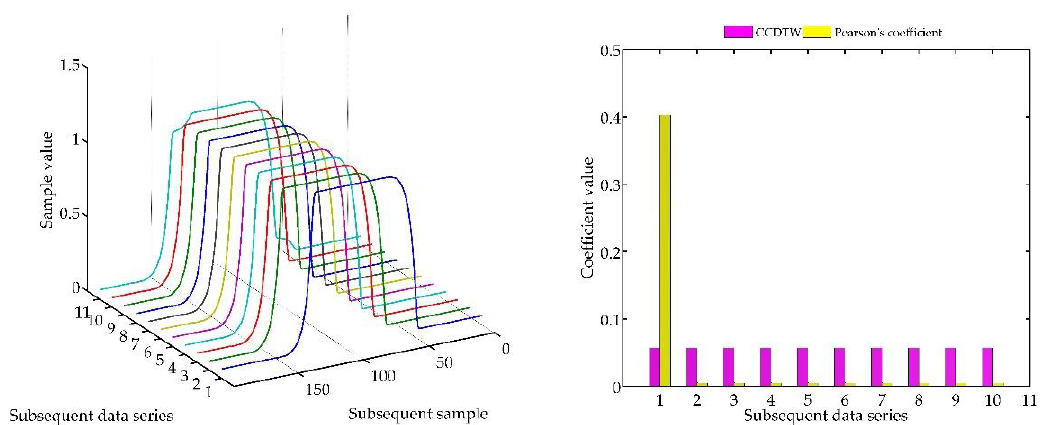
Figure 8. Simulation results achieved for data shifted by − 15 samples for the first series (blue line) for r ampl = 2.